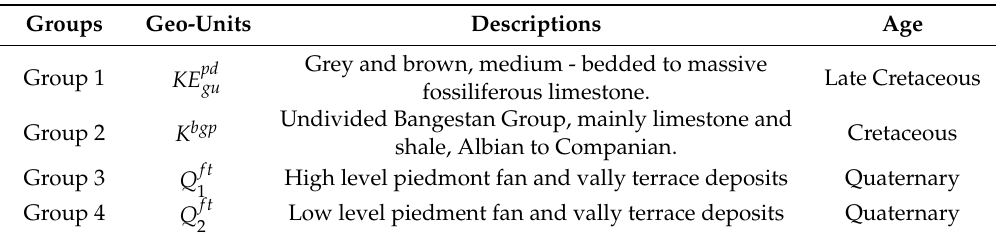
Table 2. Brief description of the lithology of the study